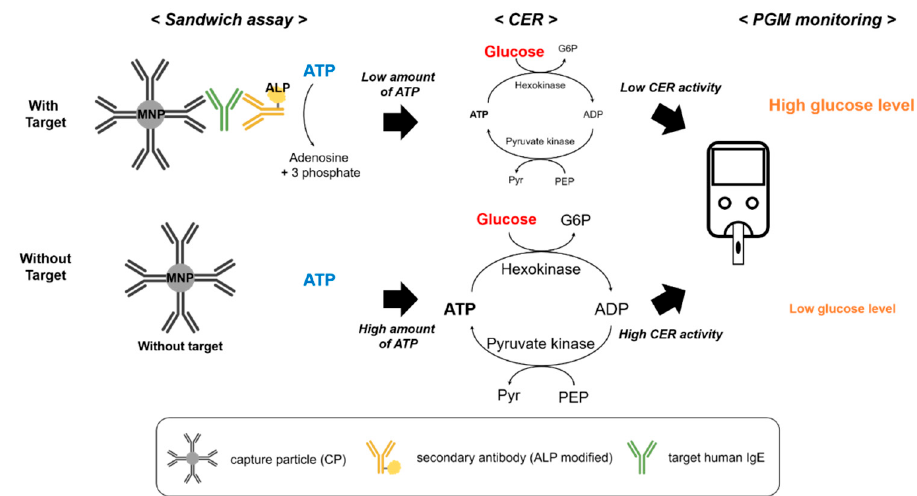
Figure 1. Schematic illustration of the IgE detection method based on a CER utilizing portable personal glucose meter. The overall assay process involves the formation of a sandwich assay comprising CP, target IgE, and ALP-modified secondary antibody, as well as CER promoted by residual ATP, which is decomposed by ALP.